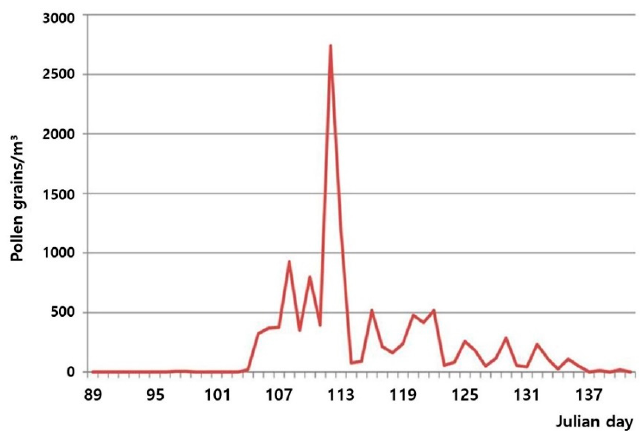
Figure 4. Daily emission of Quercus pollen in the spring. The x -axis represents the Julian day, and the y -axis represents the number of pollen grains collected during the day in the Burkard trap.